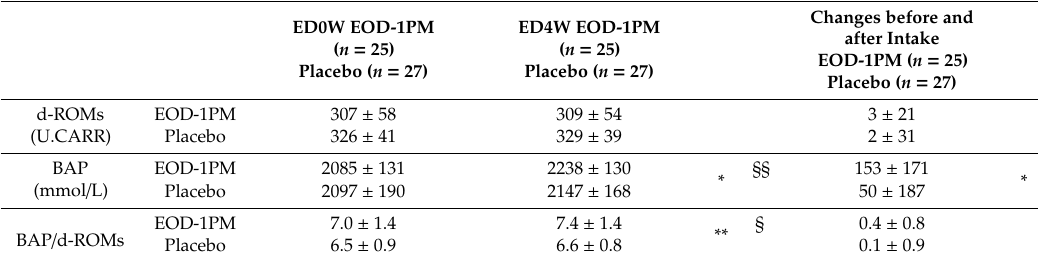
Table 3. The concentration of oxidative stress and antioxidant markers at facility arrival on the examination